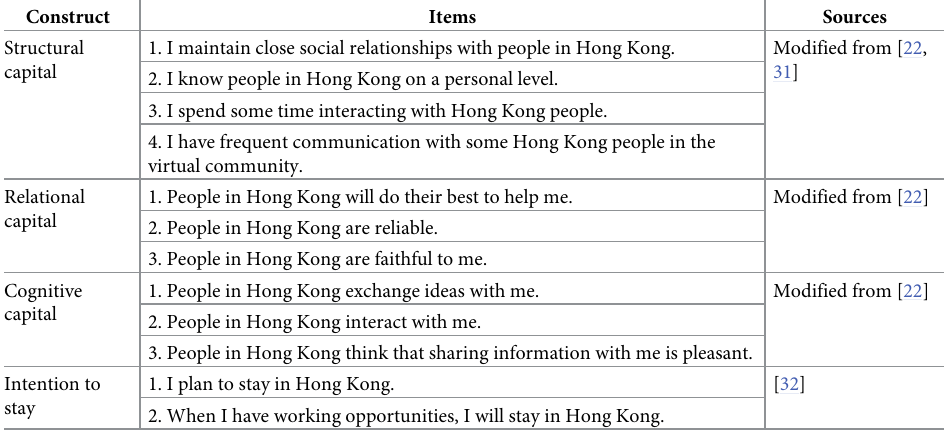
Table 1. Questionnaire items.